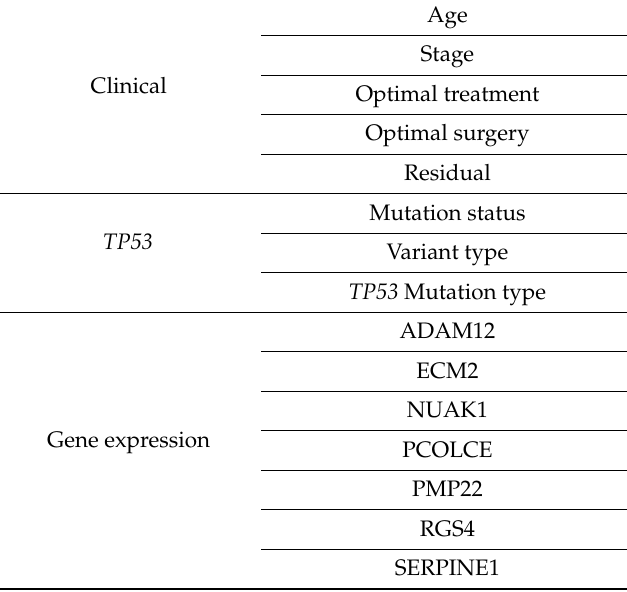
Table A1. Clinical-molecular characteristics from the resulting cluster analysis in Figure 3. The order of the variables is the same than in the